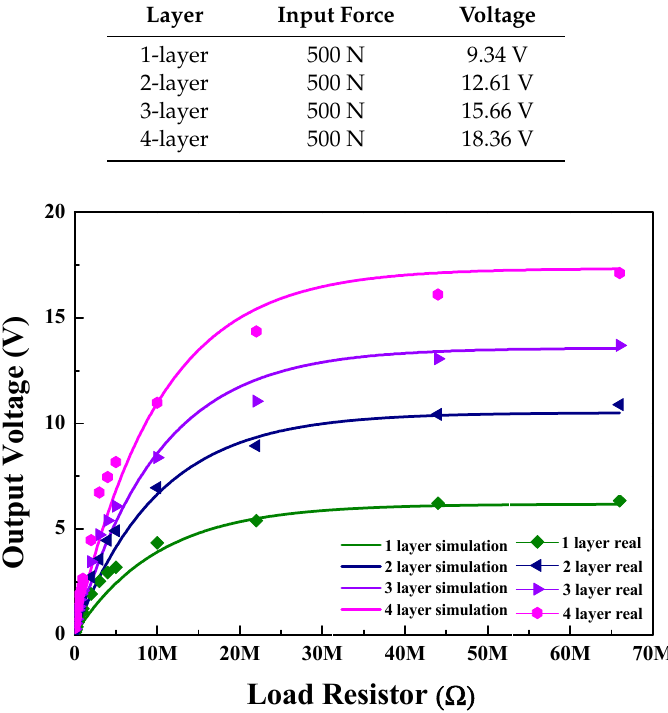
Figure 8. Generated output voltages of multilayered BS-PT piezoelectric ceramics obtained by varying the load resistors under the application of a mechanical force of 500 N.